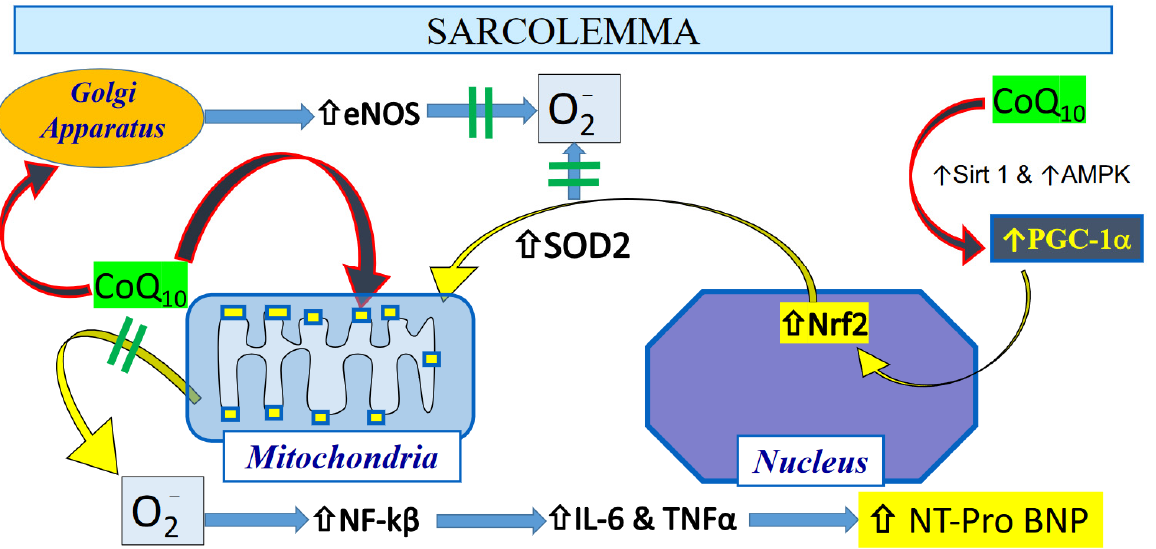
Figure 5. The possible mechanism of protection of the heart following administration of CoQ 10 relates to a direct antioxidant effect as well as an indirect effect on mitigating inflammatory pathways that can lead to increased NT-Pro BNP levels in stressed heart tissue [2]. Permission was granted to reproduce the schema.